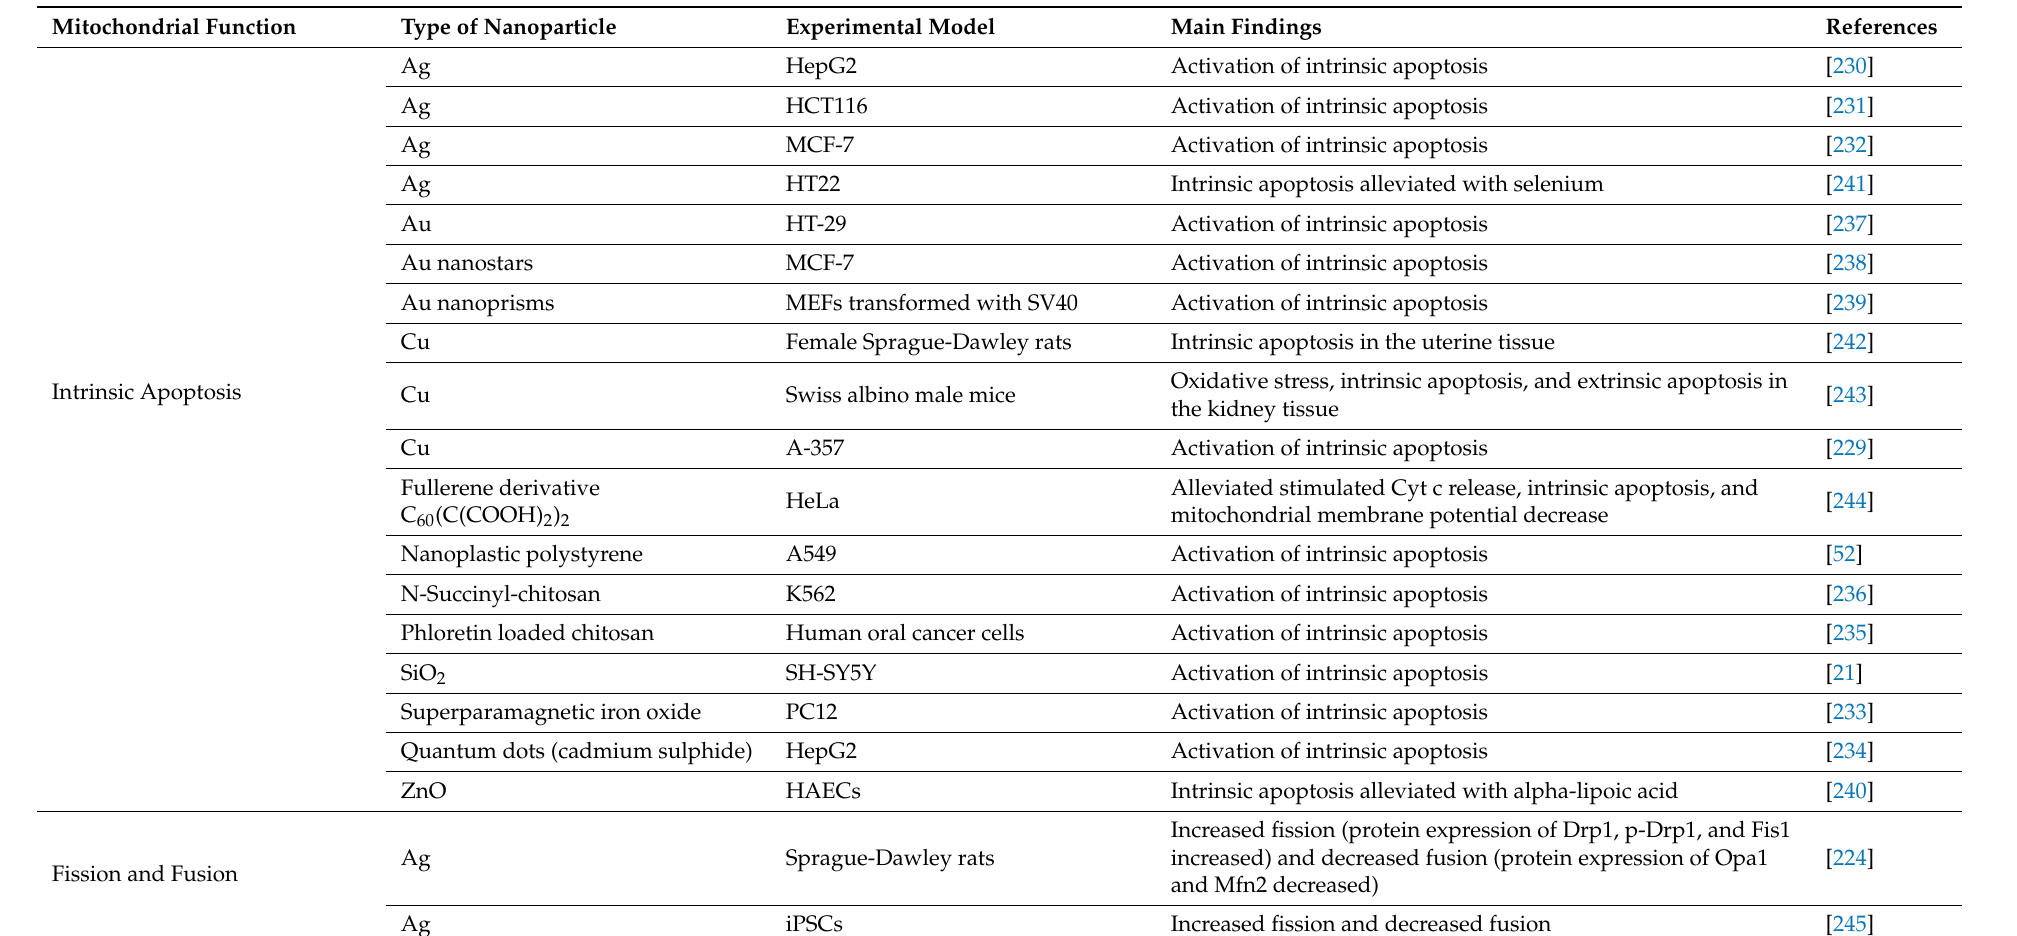
Table 5. Effects of nanoparticles on mitochondrial